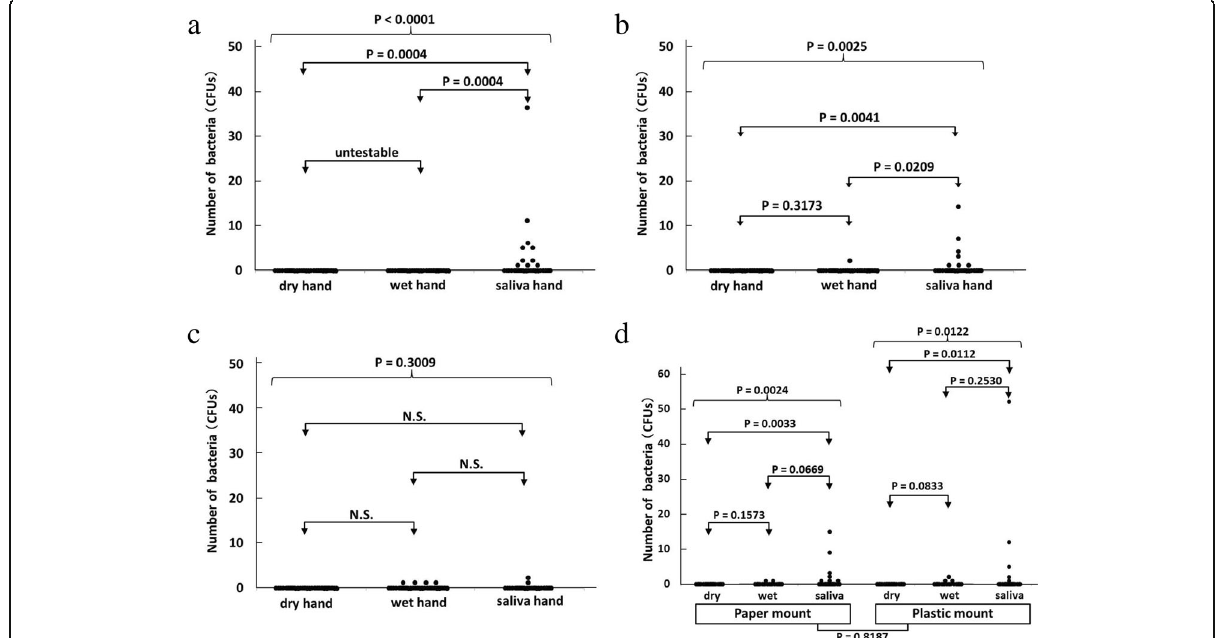
Fig. 5 a Contamination of the lateral surface of the needle hub in the push-off top method (dry/wet/saliva). b Contamination of the bottom surface of the needle hub in the push-off top method (dry/wet/saliva). c Contamination of the inner lumen of the needle hub in the push-off top method (dry/wet/saliva). d Contamination of the needle hub in the push-off top method (paper/plastic). All bacterial data obtained under dry and wet conditions were zero, and, thus, a statistical test was not performed. The closed testing procedure was used. First, data was compared between dry, wet, and saliva hands with a significance level of 5%, and if not significant, we concluded that there are no significant differences for any pairwise comparisons and stopped the testing procedure. Second, pairwise comparisons were performed with a significance level of 5% for each test if the first step was significant. Three group comparisons were p = 0.0001, 0.0025, 0.3009, 0.0024, and 0.0122 for the lateral surface ( a ), bottom surface ( b ), inner lumen ( c ), paper-mount ( d ), and plastic-mount ( d ),